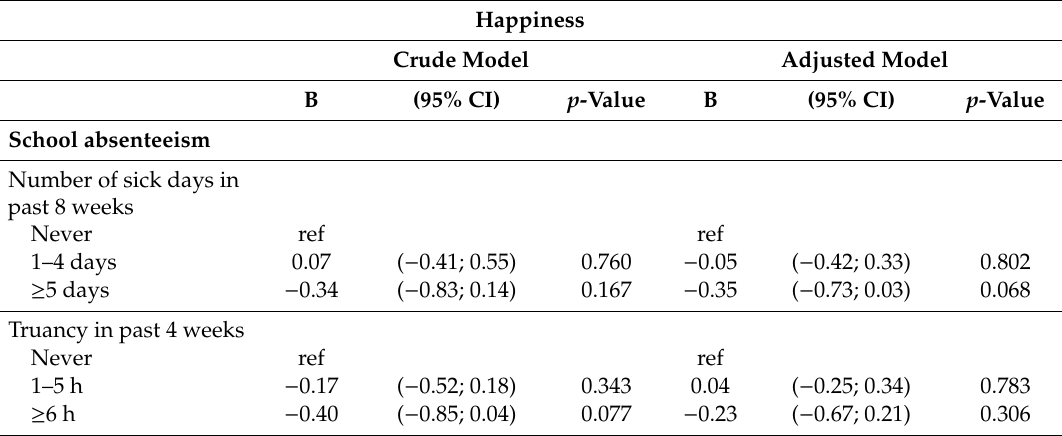
Table 4. Results from the multivariable general linear models evaluating the association of school absenteeism with